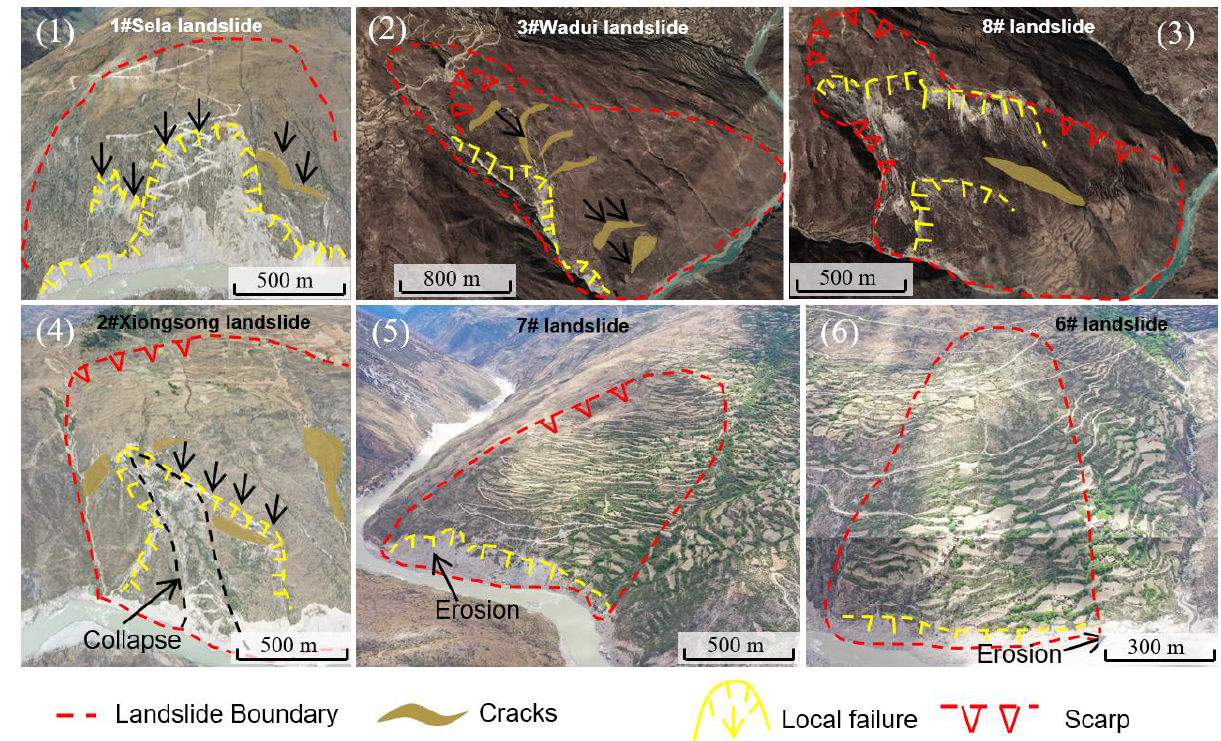
Figure 8. Fracture and local failure characteristics of landslides.